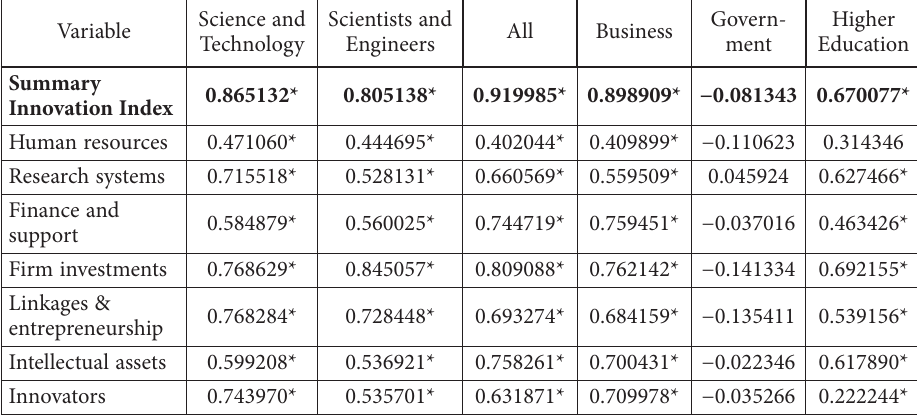
Table 2. Evaluation of dependencies between SII sub-indices and individual variables serving as weights (source: own elaboration based on the data of the European Statistical Office – Eurostat and European Commission, 2018. European Innovation Scoreboard 2018)